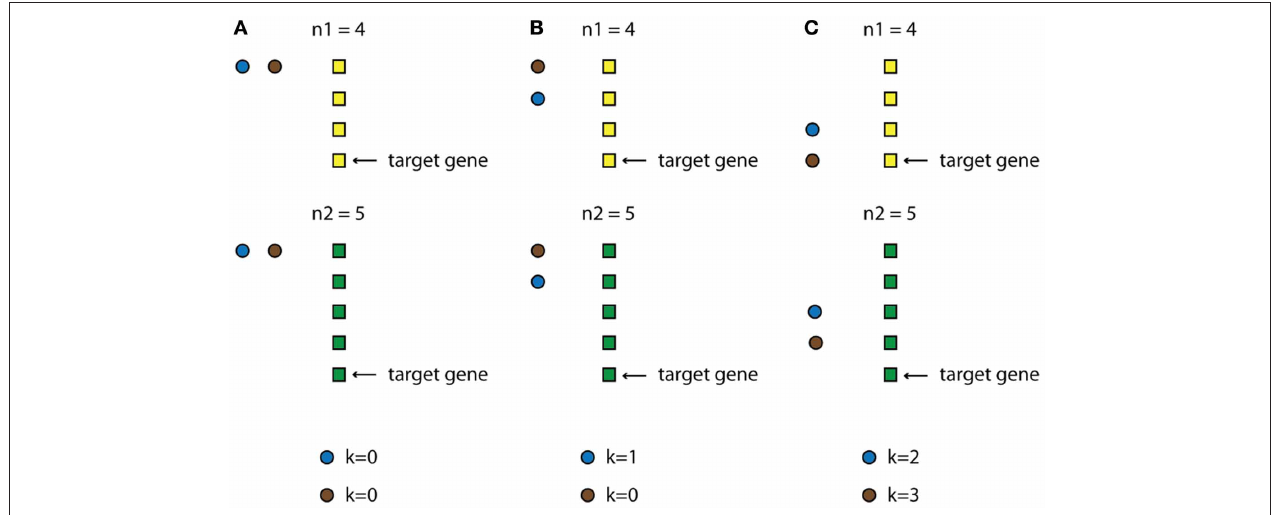
FIGURE 3 | Schematic example of how the TF-delay table is constructed. Assume a category that consists of two conditions, with n1 and n2 time points, respectively (black and white rectangles), and a module that, for simplicity, is regulated by two upper-layer TFs (black and gray circles). The condition with the smallest number of time points is n1 so this will be the “leading” condition. Imagine that the target gene is expressed at time point n 1 = 4 (This ranges from 1 to 4,